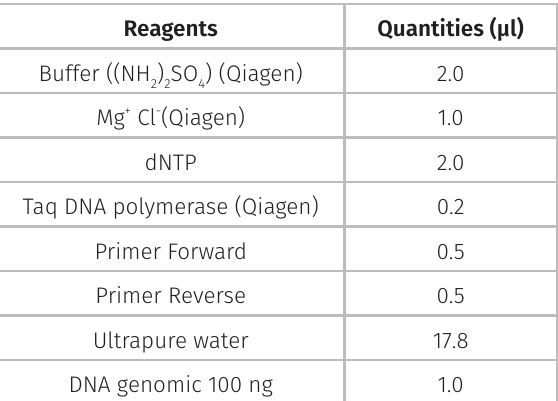
Table I. Quantities of each reagent used in the preparation of the PCR mix, to the CSN1S1 and CSN3